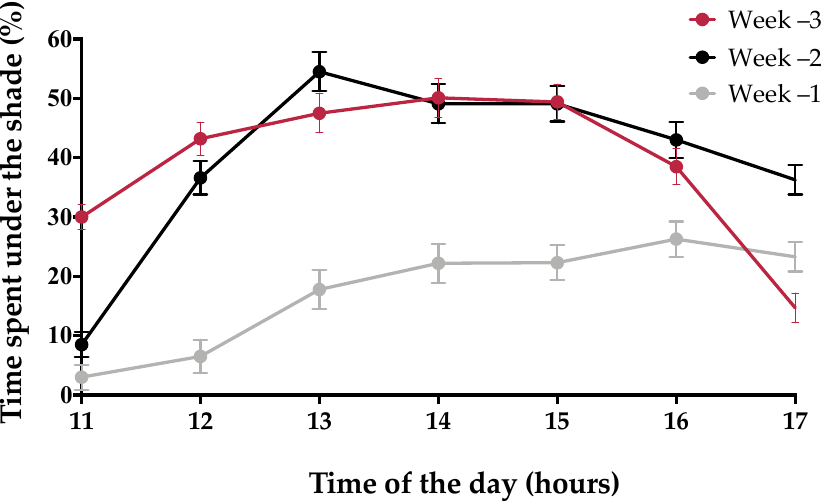
Figure 3. Mean ( ± SE) percentage of time prepartum cows spent beneath the shade in different weeks prior to calving ( n = 12). The results are shown for 60-min intervals from 11:00 h to 17:59 h.